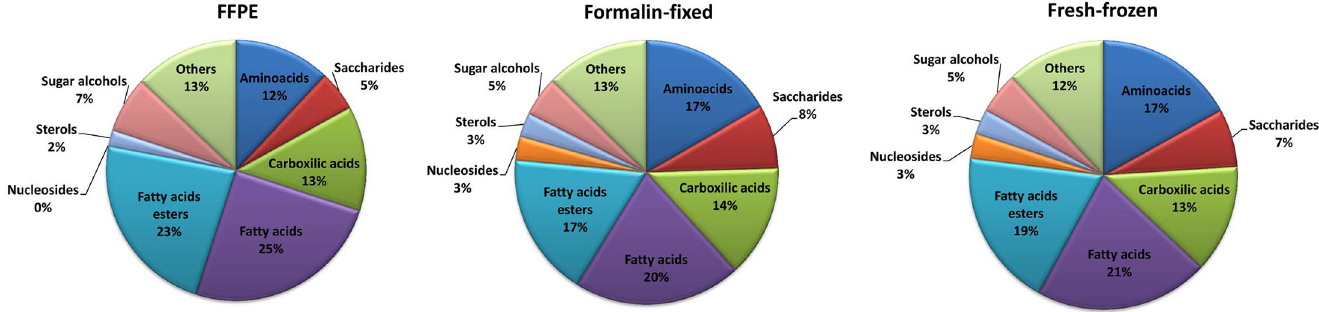
Fig 3. Contribution of different classes of metabolites detected in extracts from fresh-frozen, formalin-fixed or FFPE specimens of mouse kidney (samples were fixed with formalin for 24h).